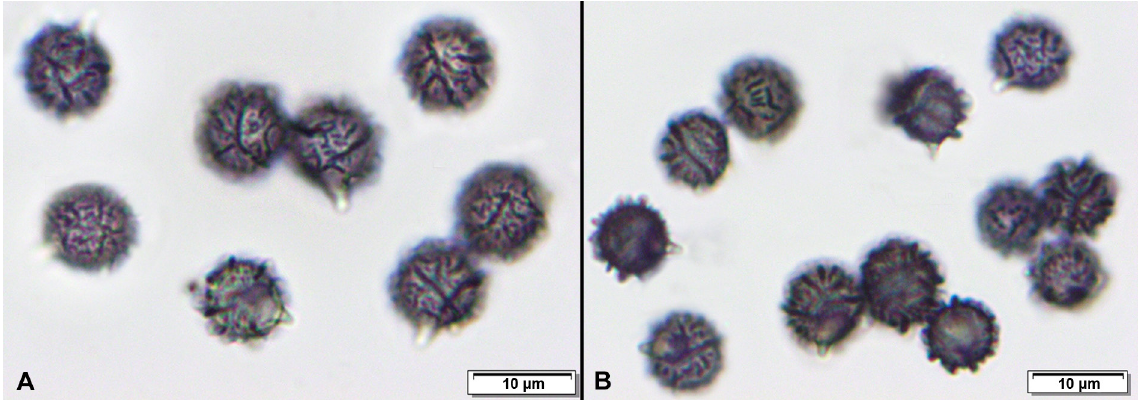
Fig. 4. Basidiospores in Melzer’s reagent. A . Basidiospores of Russula indosenecis A.Ghosh, D.Chakr., K.Das & Buyck sp. nov. B . Basidiospores of Russula pseudosenecis A.Ghosh, D.Chakr., K.Das & Buyck sp.